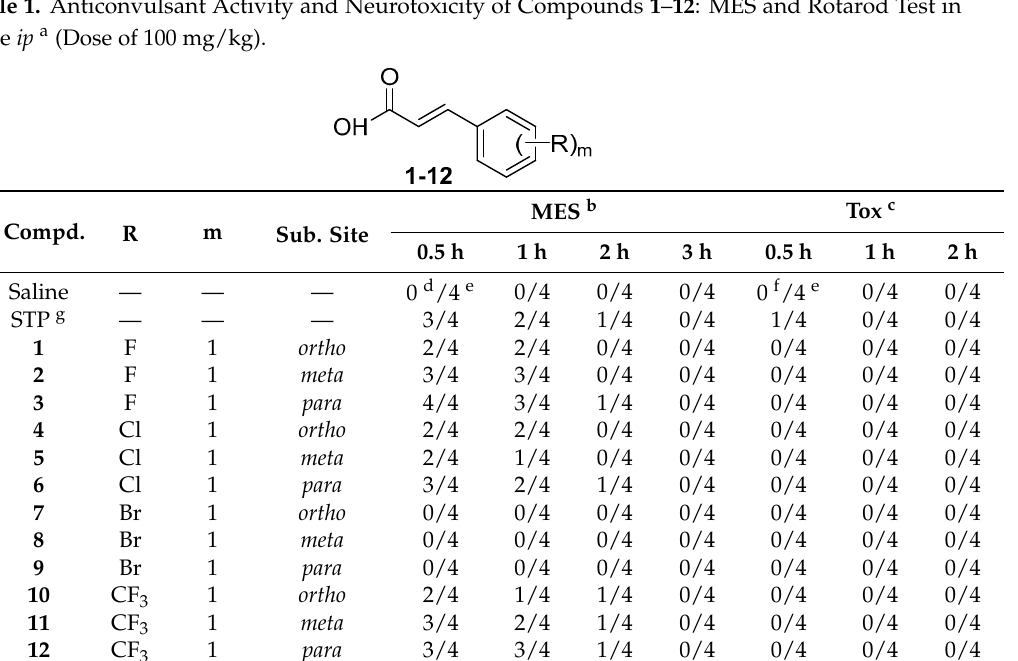
Table 1. Anticonvulsant Activity and Neurotoxicity of Compounds 1 – 12 : MES and Rotarod Test in Mice ip a (Dose of 100 mg/kg).